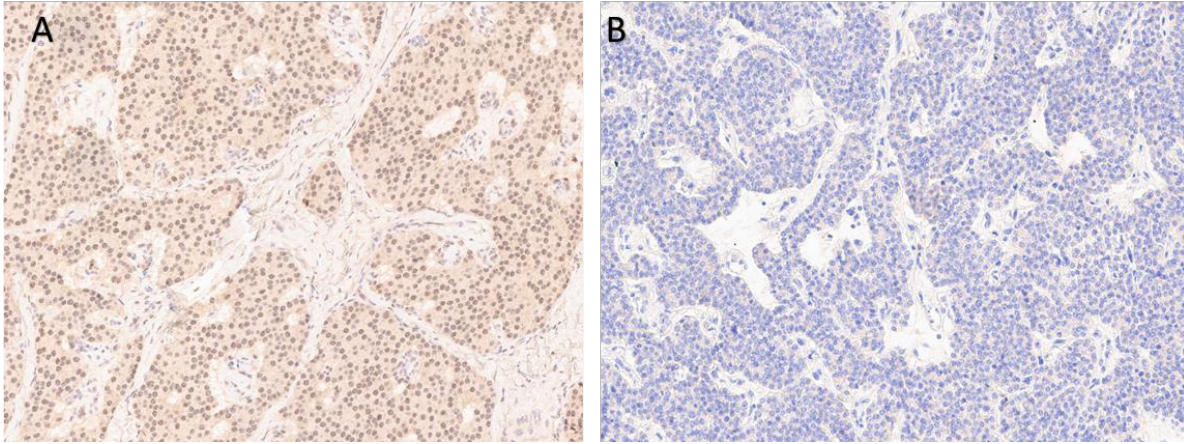
Figure 5. Menin IHC staining in pancreatic NET and parathyroid carcinoma. ( A ) Pancreatic tumor tissue with nuclear and cytoplasmic expression (control tissue); ( B ) Negative menin expression in parathyroid cancer.